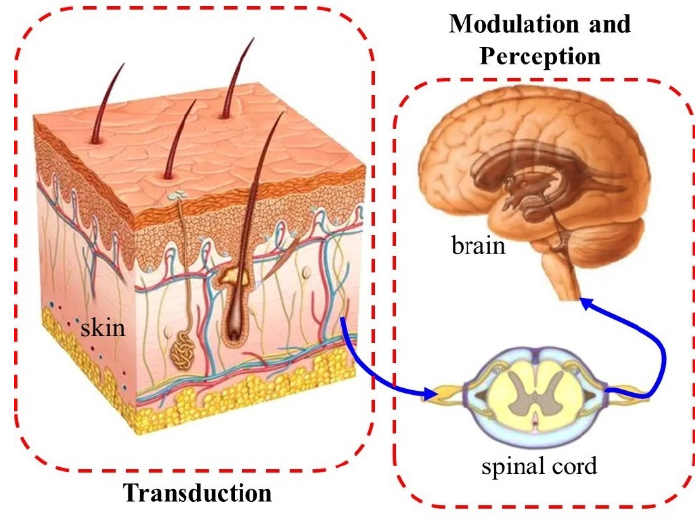
Figure 1. Diagram of the skin pain model.